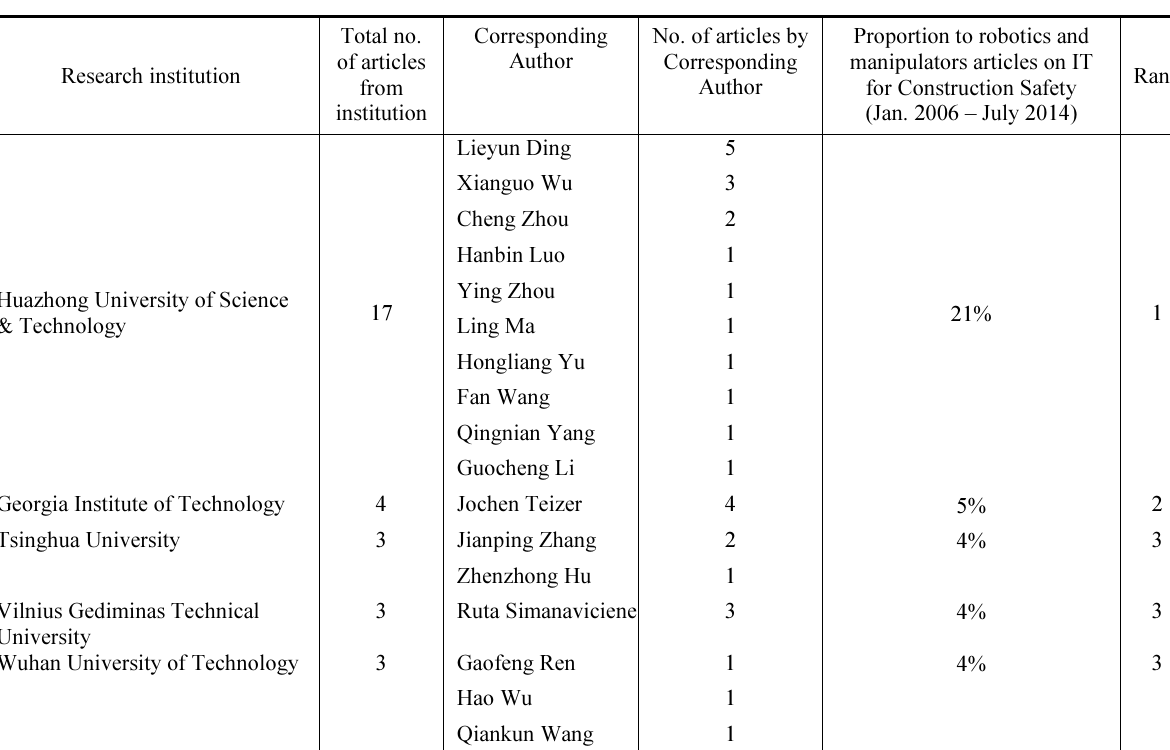
Research institution